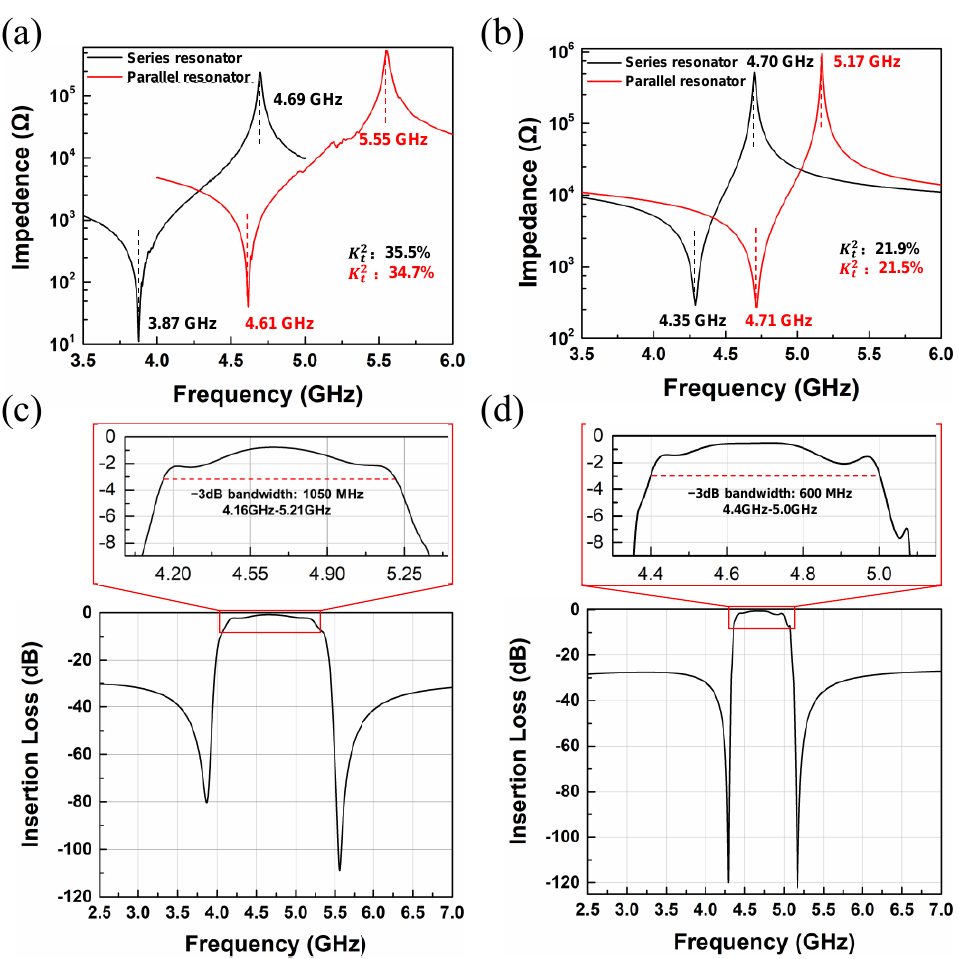
Figure 7. ( a ) The impedance curves of an XBAR with pure LiNbO 3 film for the n79 filter. ( b ) The impedance curves of an XBAR with SiO 2 /LiNbO 3 composite film for the n79 filter. ( c ) The response of the proposed filter with pure LiNbO 3 film. ( d ) The response of the proposed filter with SiO 2 /LiNbO 3 composite film.